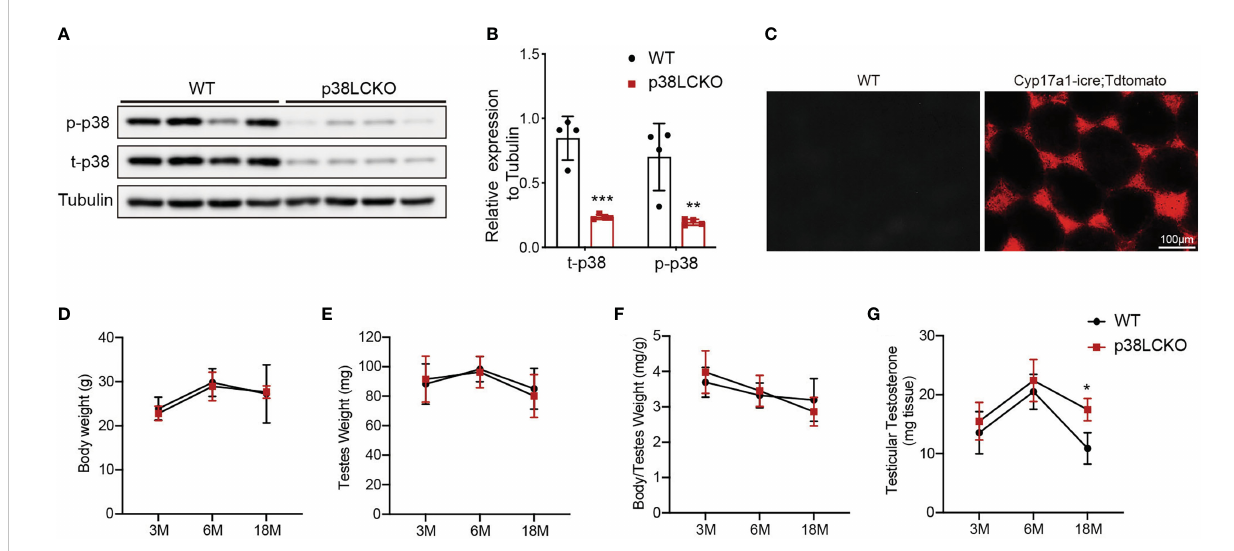
FIGURE 4 General features and serum testosterone levels of p38LCKO and WT mice. (A) The protein levels of t-p38 MAPK and p-p38 MAPK were analyzed by immunoblot. (B) Quantitative analyses for the protein levels. (C) Red fl uorescence of Tdtomato in testis. The body weight (D) , testis weight (E) , ratio of testis to body weight (F) , and testicular testosterone (G) of p38LCKO and WT mic at 3-,6-, and 18- months of age. *p<0.05, **p<0.01,